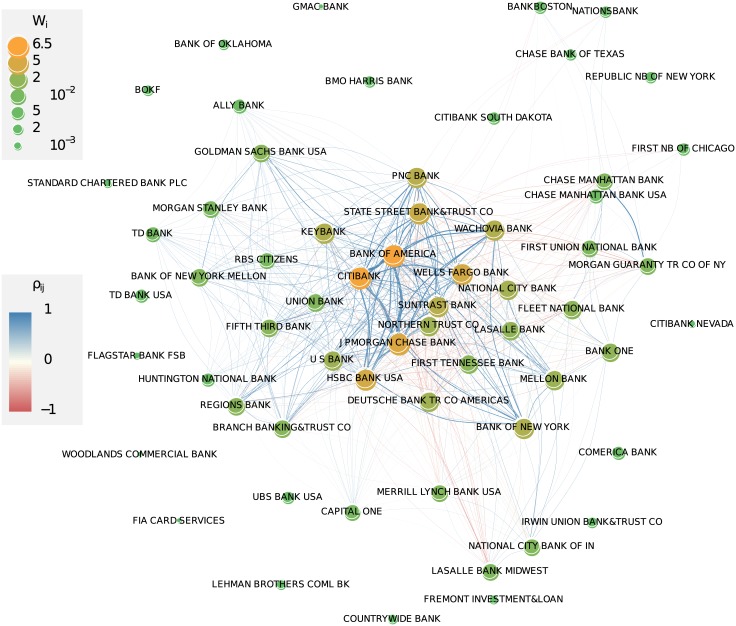
Weighted network based on the co-occurrence and activity of financial institutions in the top 25 ranking, aggregated over all quarter years.The coding of size and color of nodes and links are the same as in Fig 7, but the w
ij and W
i are calculated from the l
ij as given by Eq (3) i.e., dependent on the ranks. The time resolved network is shown in Fig D in S1 Appendix. The aggregated network should be compared with Fig 7 where activities are not taken into account.